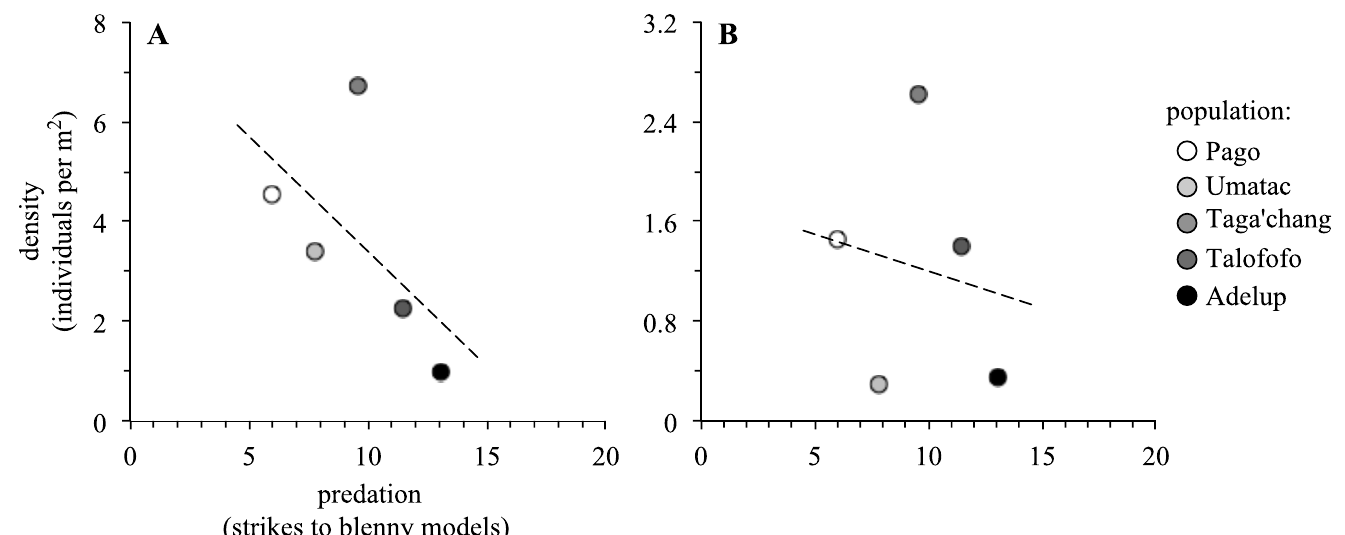
Fig 2. The relationship between predation and ( A ) adult density and ( B ) juvenile density. Symbols are shaded according to the level of predation, from white (low predation) to black (high